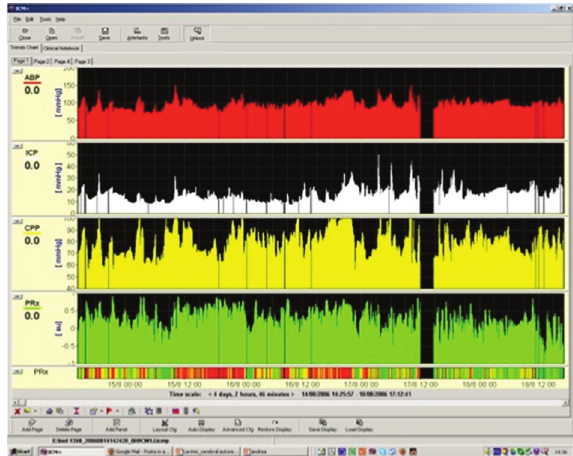
Figure 4: Example of multiple days monitoring of PRx along with ICP, ABP, and CPP where a patient attained good outcome after severe head injury. Image extrapolated from ICM+ software. ICP: intracranial pressure. ABP: arterial blood pressure. CPP: cerebral perfusion pressure. PRx: pressure reactivity